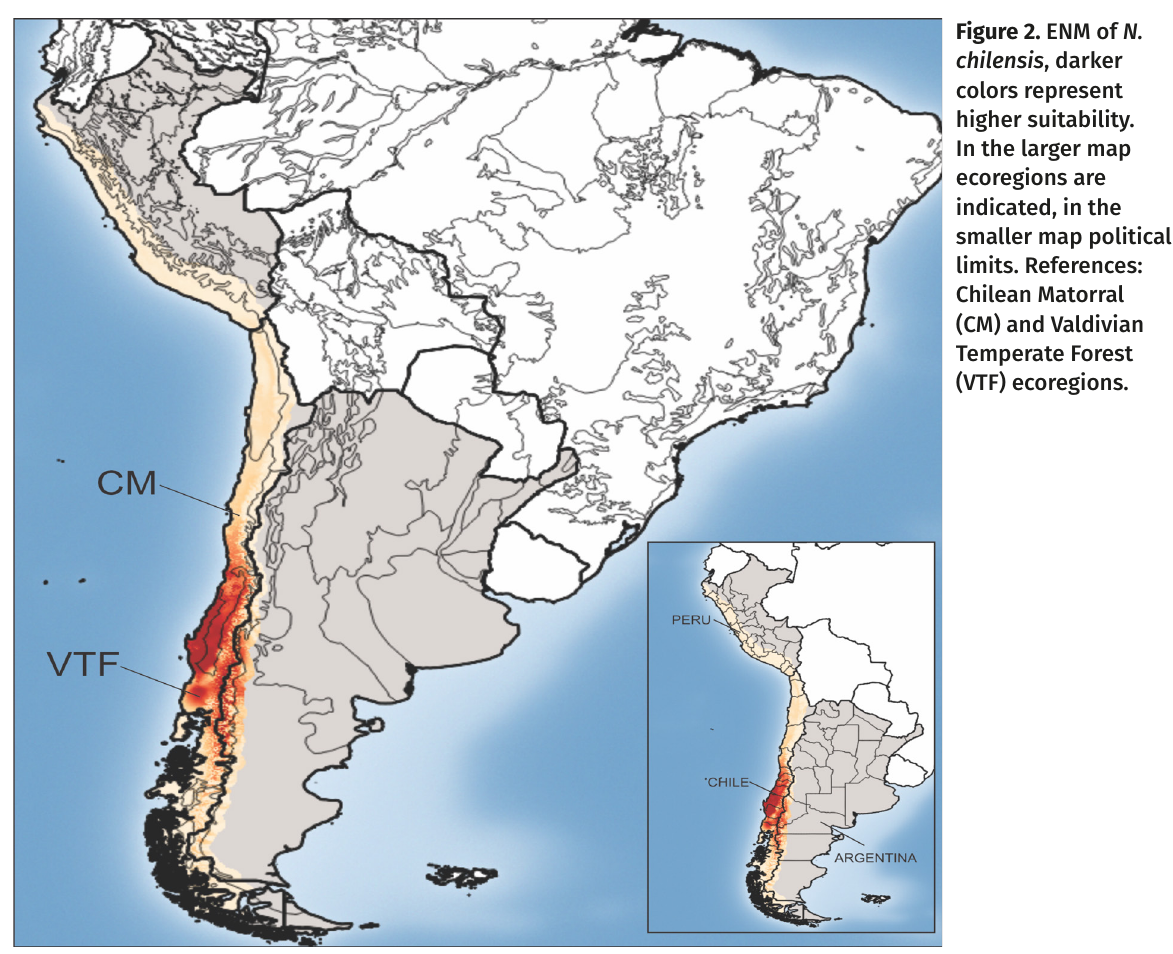
Figure 2. ENM of N. chilensis , darker colors represent higher